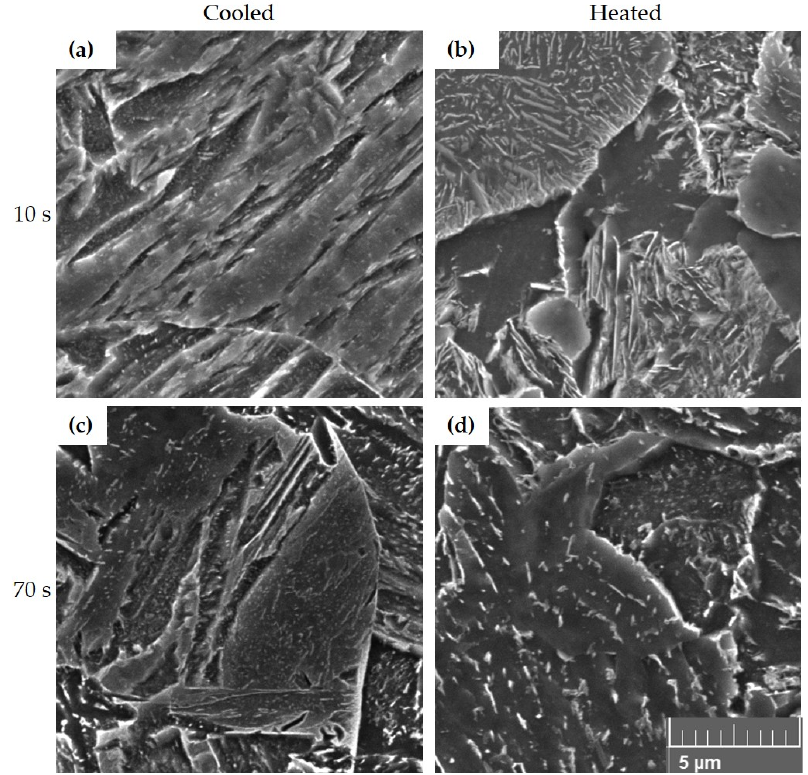
Figure 7. Microstructures of 22MnB5 after hot stamping under a scanning electron microscope: ( a ) 10s_C, ( b ) 10s_H, ( c ) 70s_C, ( d ) 70s_H.